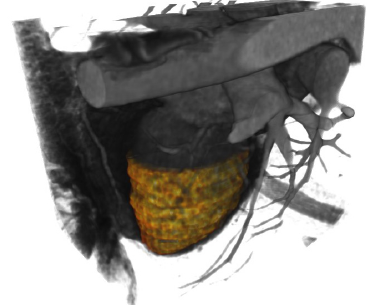
Figure 16. A whole cardiac volume and its left ventricle segmented.